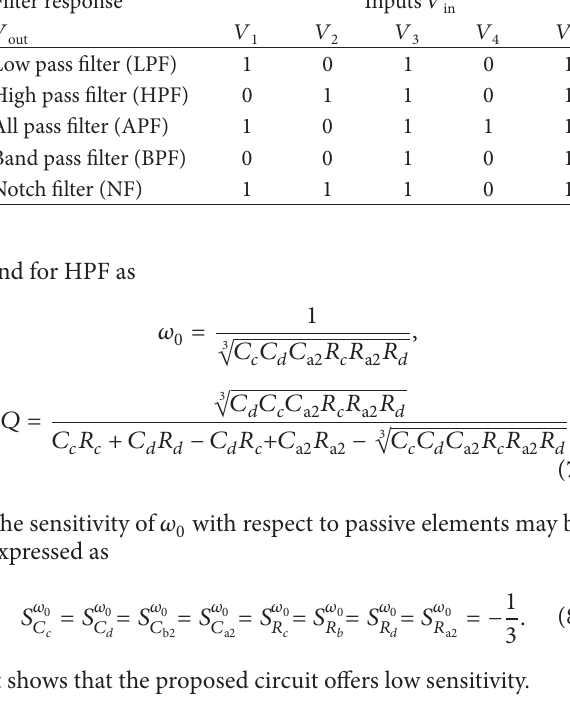
F 6: Frequency response of third order highpass